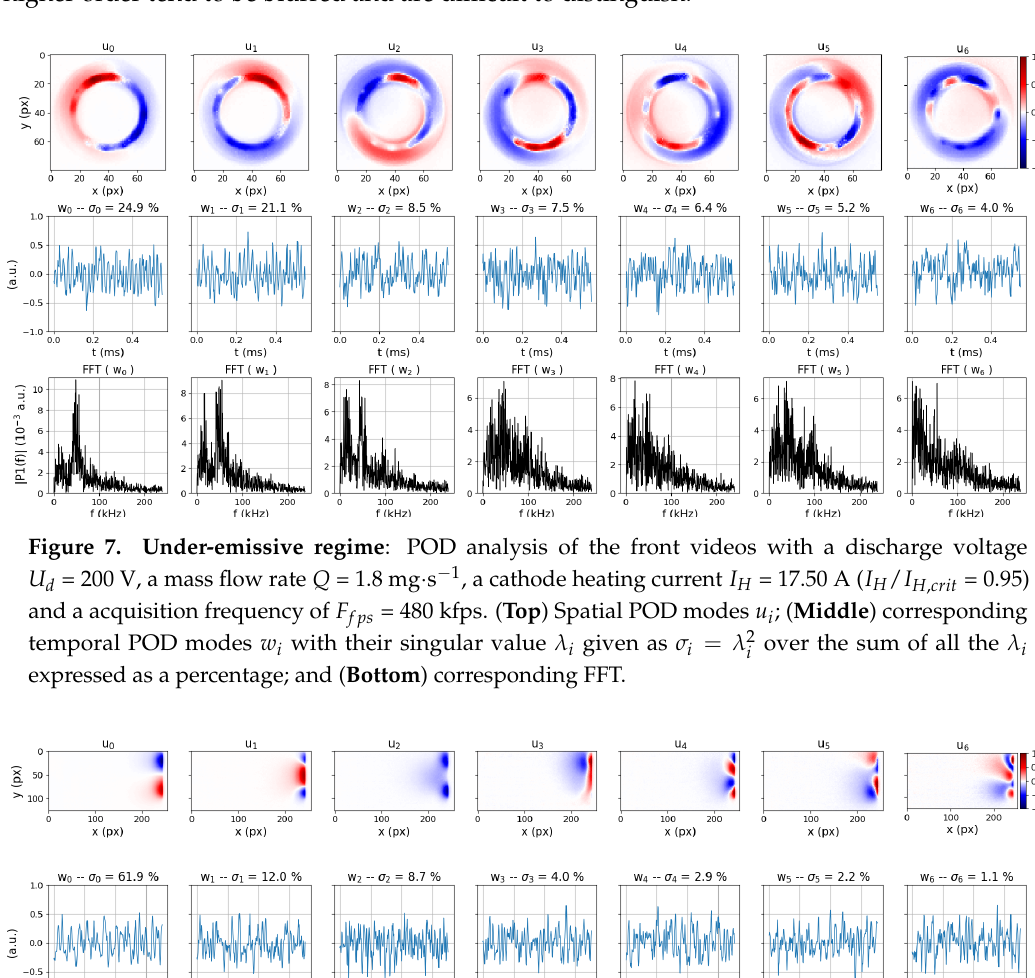
Figure 8. Under-emissive regime : POD analysis of the side videos with a discharge voltage U d = 200 V, a mass flow rate Q = 1.8 mg · s − 1 , a cathode heating current I H = 17.50 A ( I H / I H , crit = 0.95) and a acquisition frequency of F fps = 300 kfps. ( Top ) Spatial POD modes u i ; ( Middle ) corresponding temporal POD modes w i with their singular value λ i given as σ i = λ 2 expressed as a percentage; and ( Bottom ) corresponding